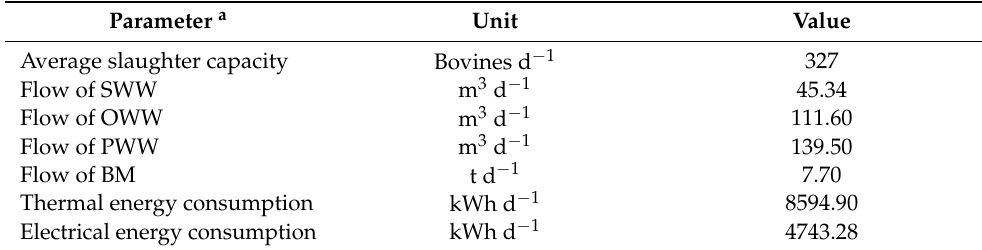
Table 1. Operational characteristics of the case study slaughterhouse.